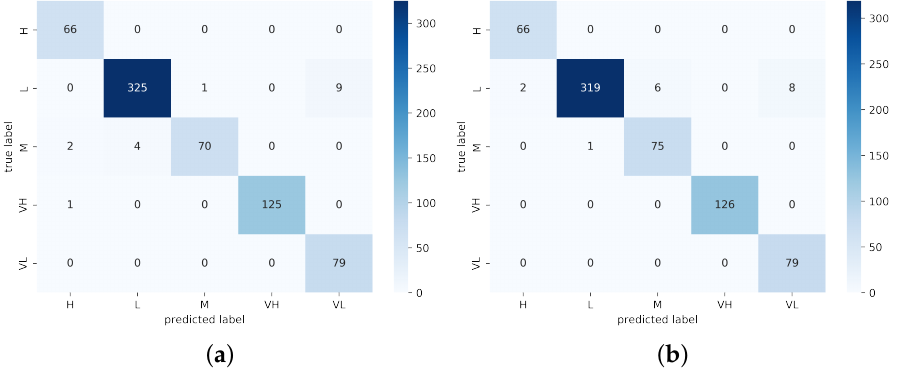
Figure 12. Confusion Matrix Heatmap of UMN Plaza 1 for ( a ) MCMS-BCNN-Attention+densenet121 and ( b )